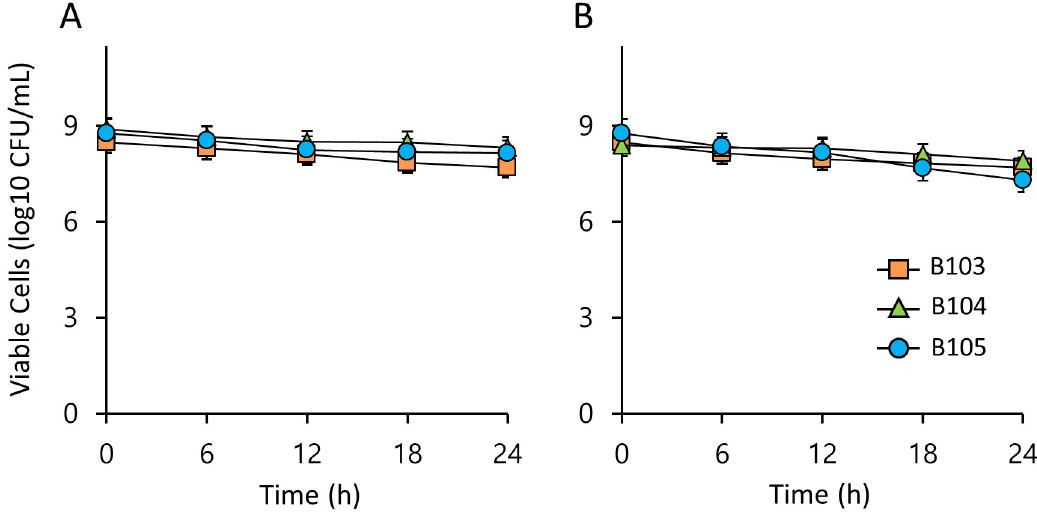
Fig 4. Survival of LAB in simulated bile juice of humans. Viable cells of LAB over time in MRS broth containing 0.1% (w/v) (A) or 0.5% (w/v) (B) bile salt. Values are means of data from triplicate experiments, with the SD indicated by vertical bars.